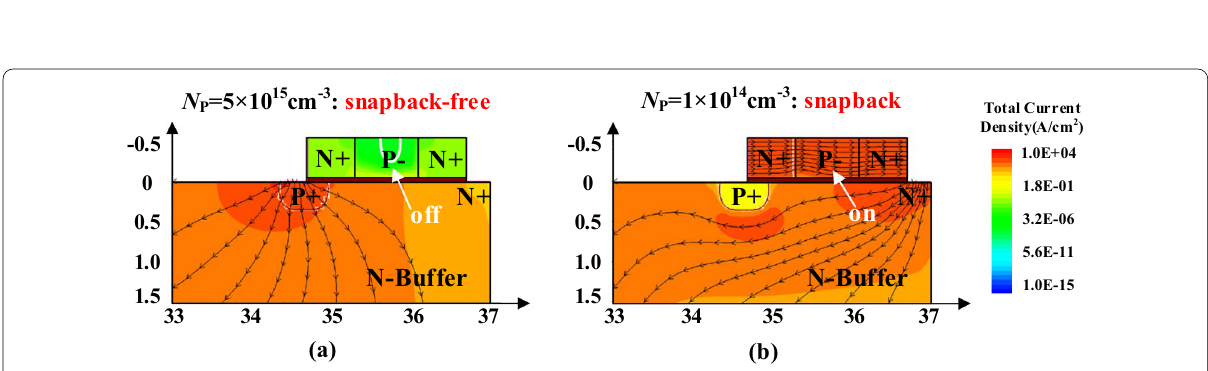
Fig. 3 Current flowlines in the forward-conducting state for the ISM RC-LIGBT ( L P N P 1 10 14 cm − = ×